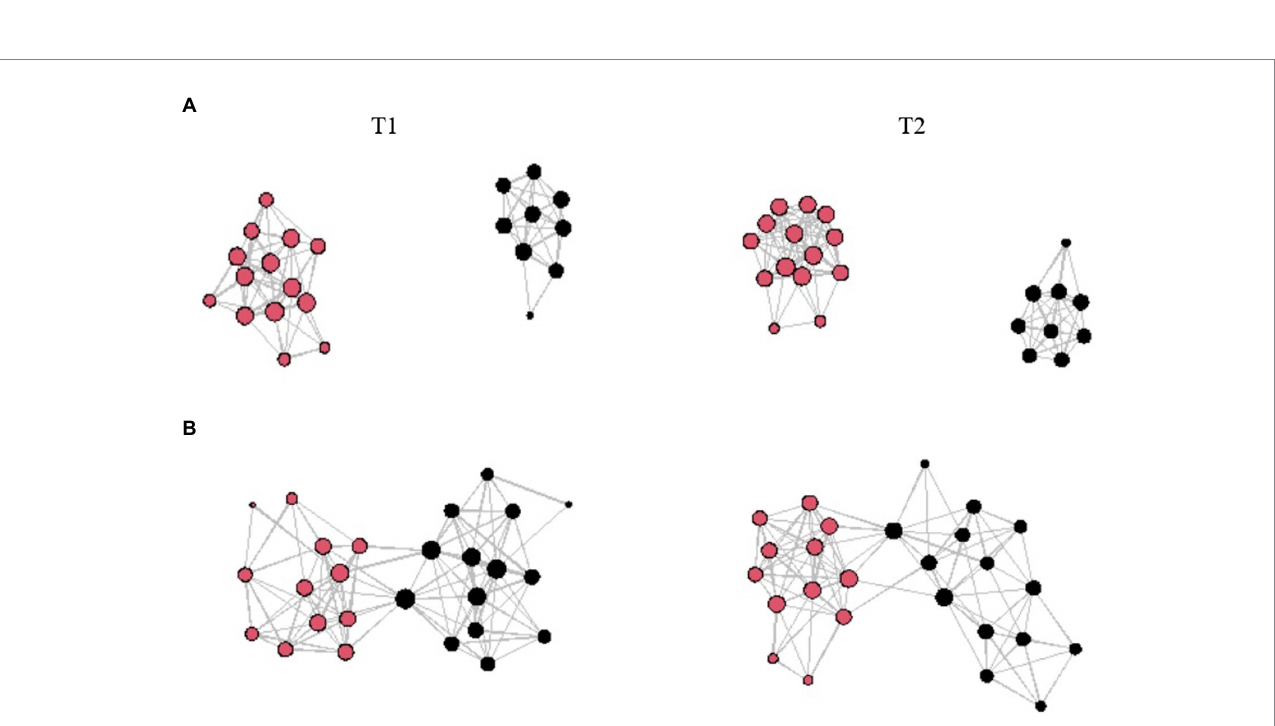
FIGURE 2 Visualized networks taking gender into account (red represents female students, black represents male students); the size of the dots reflects the degree of connections; the length of the lines does not communicative substantive information; (A) Interaction during breaks in EOtC class, (B) Interaction during breaks in comparison class; T1 = first time point; T2 = second time